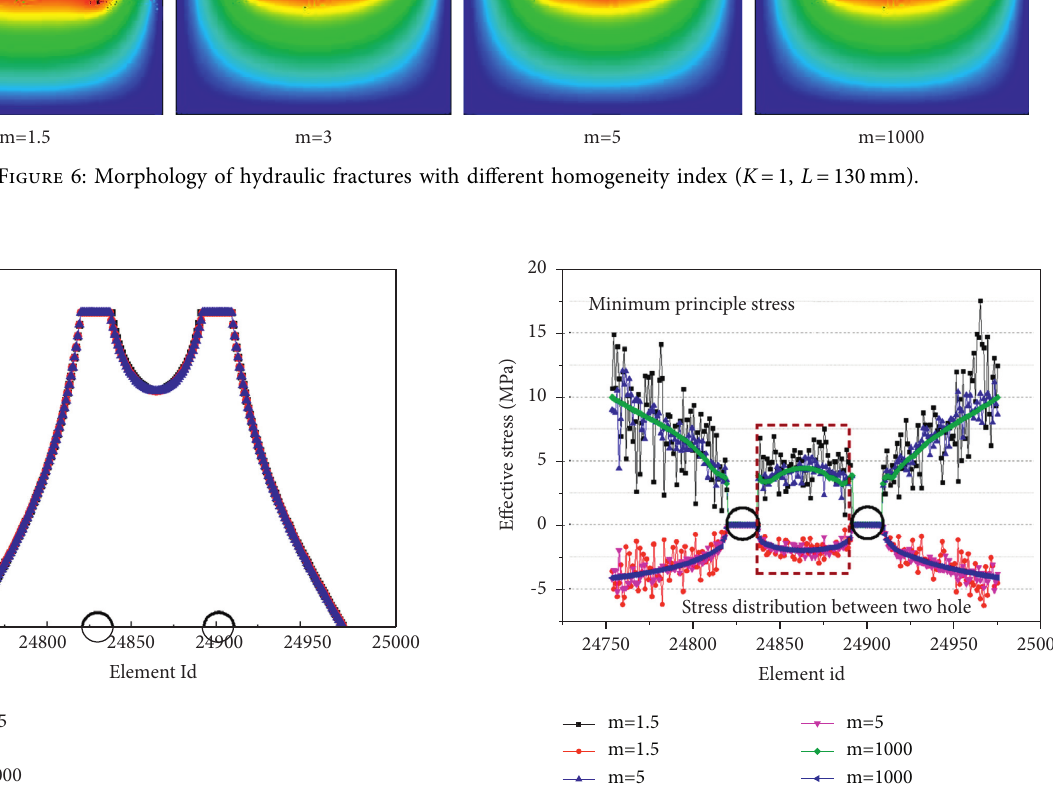
Figure 7: Pore pressure distribution along the wellbore center. Figure 8: Effective minimum principal stress distribution along the wellbore